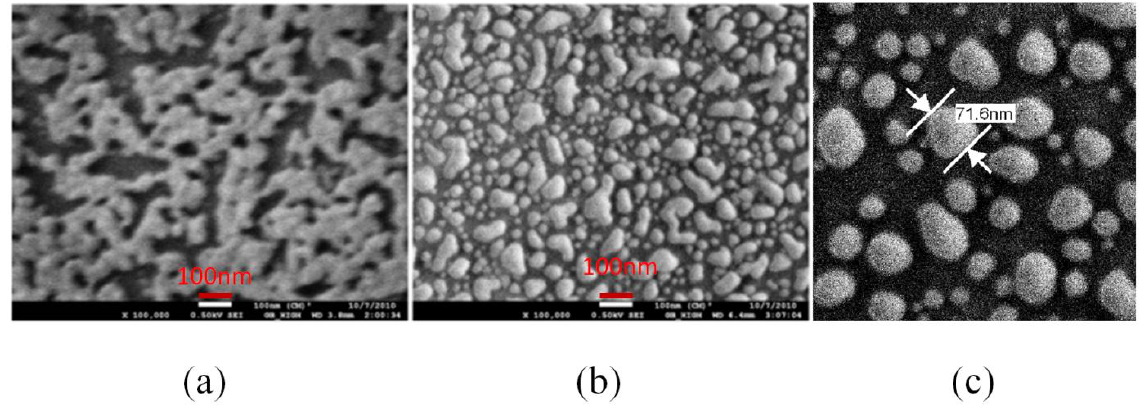
Figure 10. SEM micrographs of ( a ) nano-cluster obtained after deposition ( b ) annealed at 400–450 °C ( c ) annealed at 550–600 °C